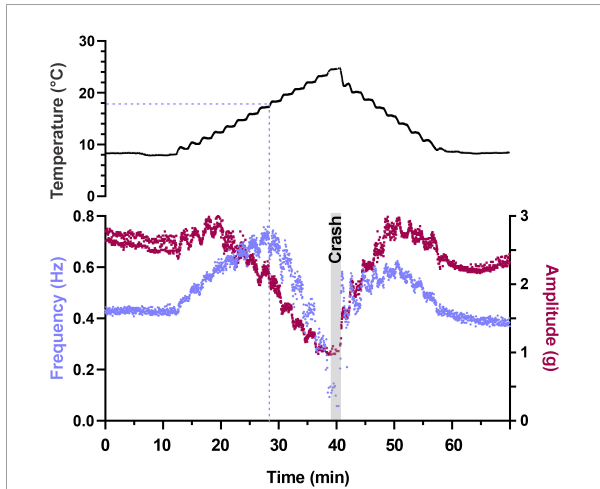
FIGURE2 Depiction of changes in heartbeat parameters as temperature is increased to its crash temperature and then decreased to baseline. Plot of two parameters that characterize the heartbeat as temperature is increased to crash in a semi-intact preparation. Instantaneous contraction frequency is plotted on the left y-axis (purple) and contraction amplitude (force) on the right y-axis (maroon) as a function of time to crash. Each data point represents a single heartbeat. Temperature steps are indicated above the plot (1.25 ◦ C increments) and the gray bar labeled “Crash” denotes the time and temperature at which the preparation crashed (fewer than two beats in 30 s). Note that contraction amplitude decreased as temperature was increased above ∼ 12 ◦ C and frequency initially increased with increased temperature. This is followed by a decrease in both parameters (amplitude decreases at temperatures greater than ∼ 14 ◦ C and frequency decreases at temperatures greater than ∼ 20 ◦ C). Also note that when temperature is stepped back to 8 ◦ C, we observe a mirrored response in both frequency and amplitude relative to the temperature ramp to